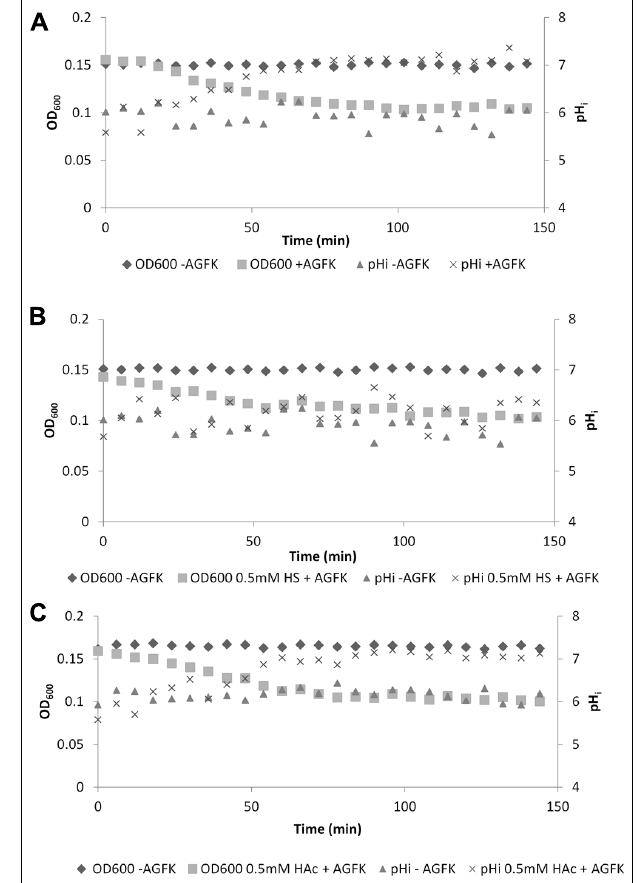
FIGURE 8 | OD 600 and internal pH during germination of B. subtilis PB2 PsspE-IpHluorin spores in medium without glucose (pHo = 6.4). Data are from a representative example. (A) Germination with AGFK; (B) germination with AGFK in 0.5 mM sorbic acid; (C) germination with AGFK in 0.5 mM acetic